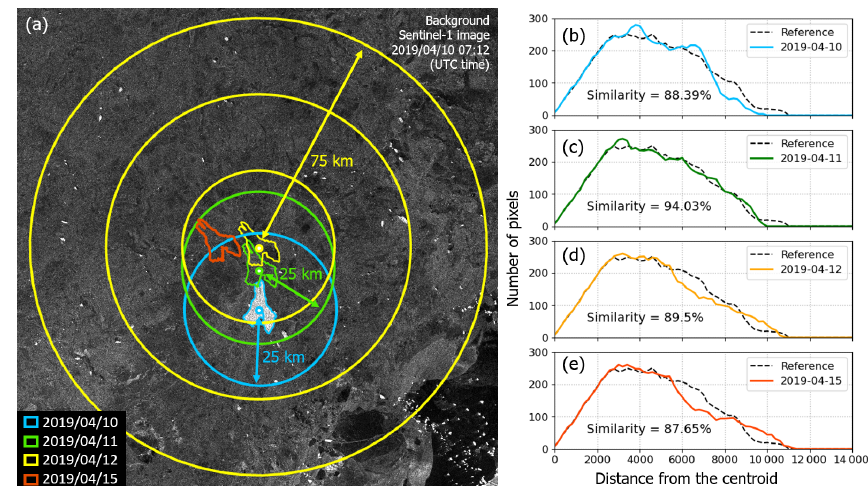
Figure 4. Tracking of the iceberg from 10 to 15 April 2020. (a) Location of detected iceberg and search radius for each day, and centroid distance histograms (CDHs) of the target iceberg for (b) 10 April 2019, (c) 11 April 2019, (d) 12 April 2019, and (e) 15 April